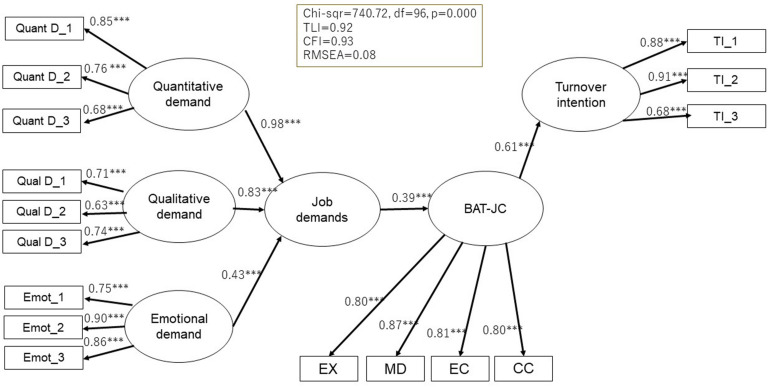
Standardized solution (Maximum Likelihood estimates) of the hypothesized model of the relations of BAT-JC with potential antecedents and consequences (N = 982). Quant D, quantitative demand; Qual D, qualitative demand; Emot, emotional demand; TI, Tuniover intention. ***p < 0.001.